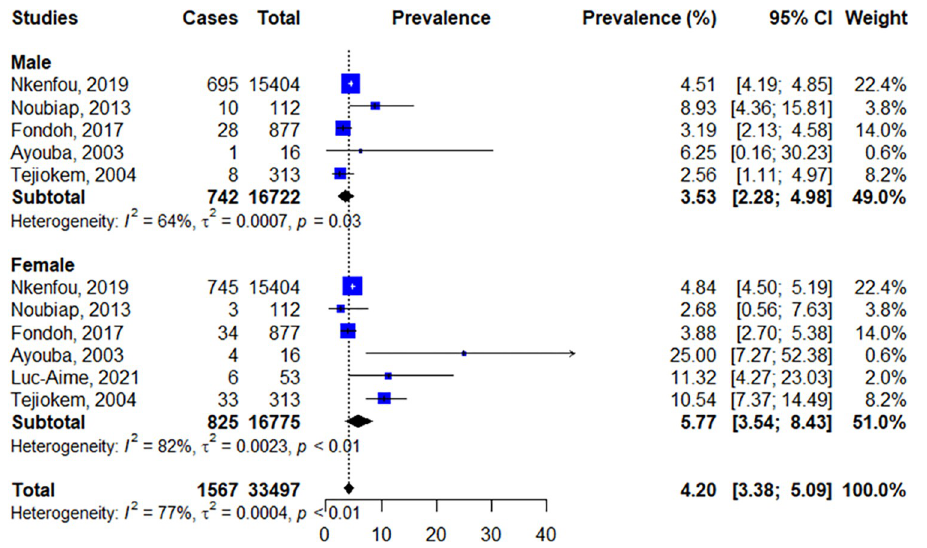
Fig 7. Forest plot of the prevalence of the MTCT according to